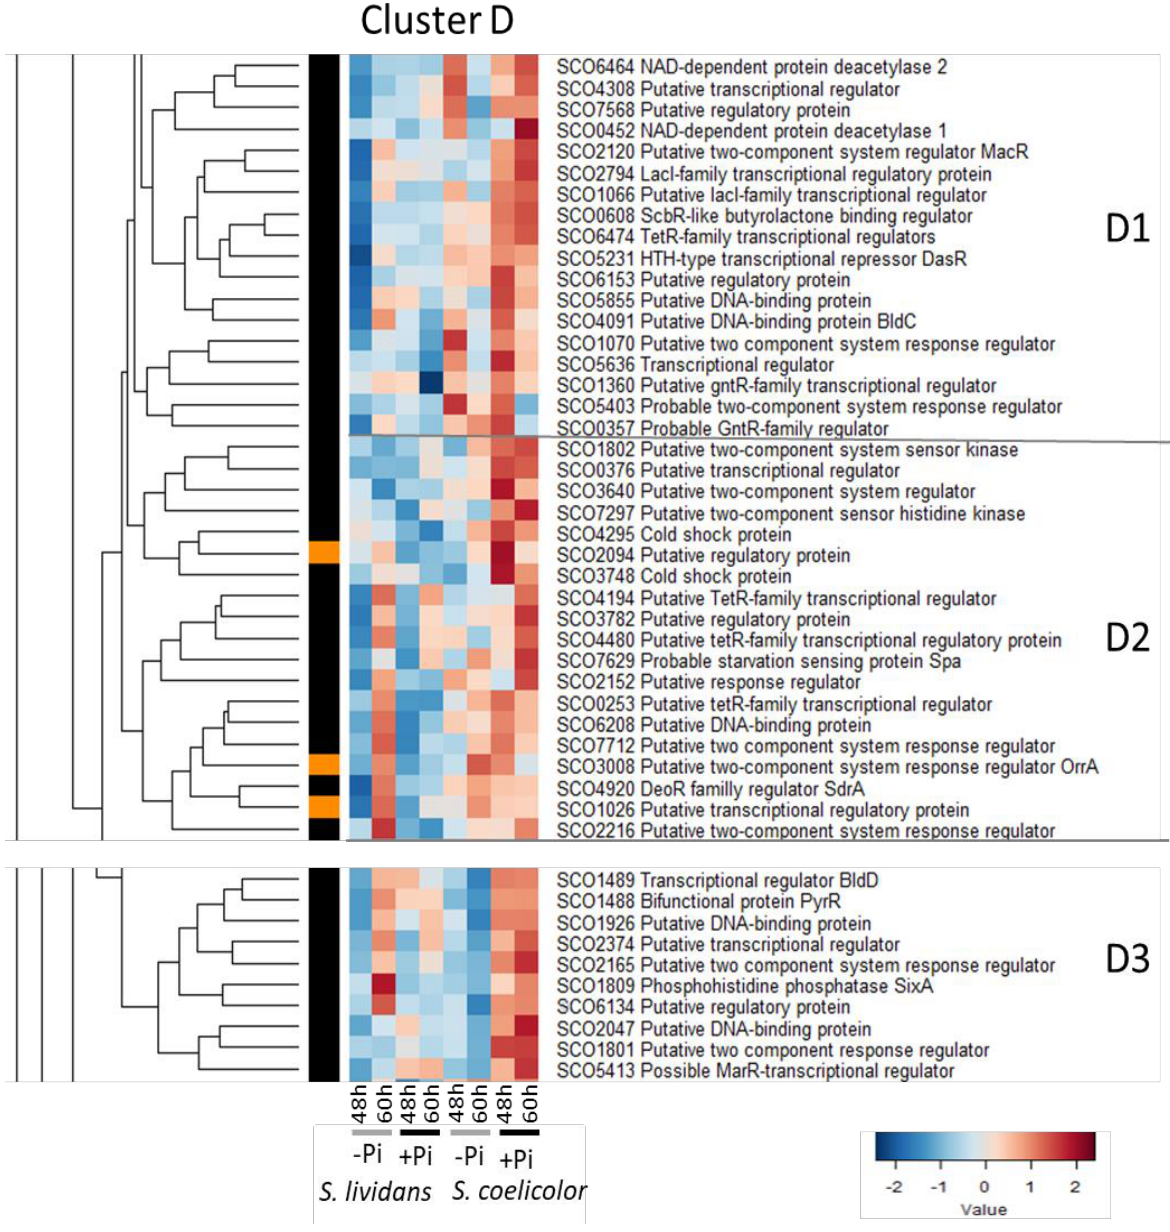
Figure 5. Cluster D, heatmap representation of transcriptional regulators and sensory histidine kinases more abundant in Pi proficiency than in Pi limitation in SC . Cluster D that can be divided into 3 sub-clusters D1, D2 and D3. The 18 regulators of sub-cluster D1 were more abundant in Pi proficiency than in Pi limitation at both time points in SC but some of them were also abundant in Pi limitation at 48 h in SC . The 18 regulators of sub-cluster D2 were more abundant in Pi proficiency than in Pi limitation at both time points in SC but some of them were also abundant in Pi limitation at 60 h in SL . The 10 regulators of sub-cluster D3 were also more abundant in Pi proficiency than in Pi limitation at both time points in SC but some of them were also abundant in Pi limitation at 60 h in SL . This cluster includes the phosphohistidine phosphatase SixA/SCO1809 whose function is unknown in Streptomyces and the pleiotropic regulator BldD/SCO1489, whose DNA binding activity is modulated by the signaling molecule c-di-GMP [122,123]. BldD has a positive impact on antibiotic production and morphological differentiation [124].